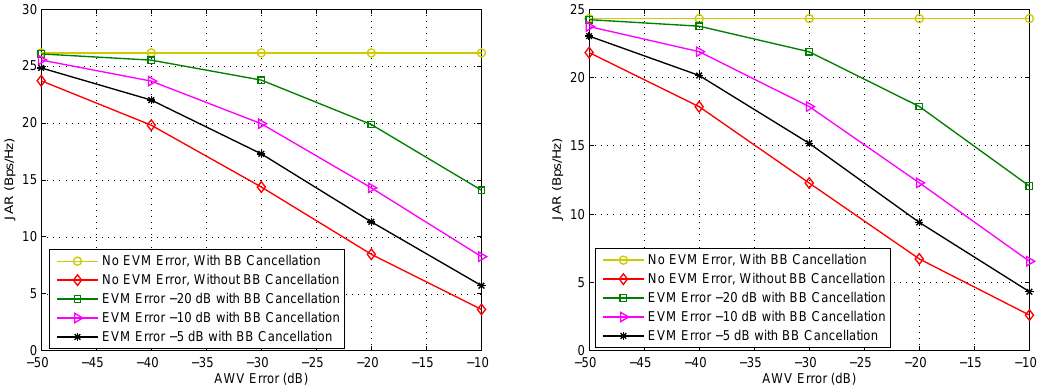
Figure 8. Effects of AWV error and EVM error on the JAR performance of ZF-Max-Power under LOS ( Left ) and NLOS ( Right ) channels. ε 12 = ε 21 = 10 dB, ε 11 = ε 22 = 50 dB, ω = 0.8 π rad, d / λ =